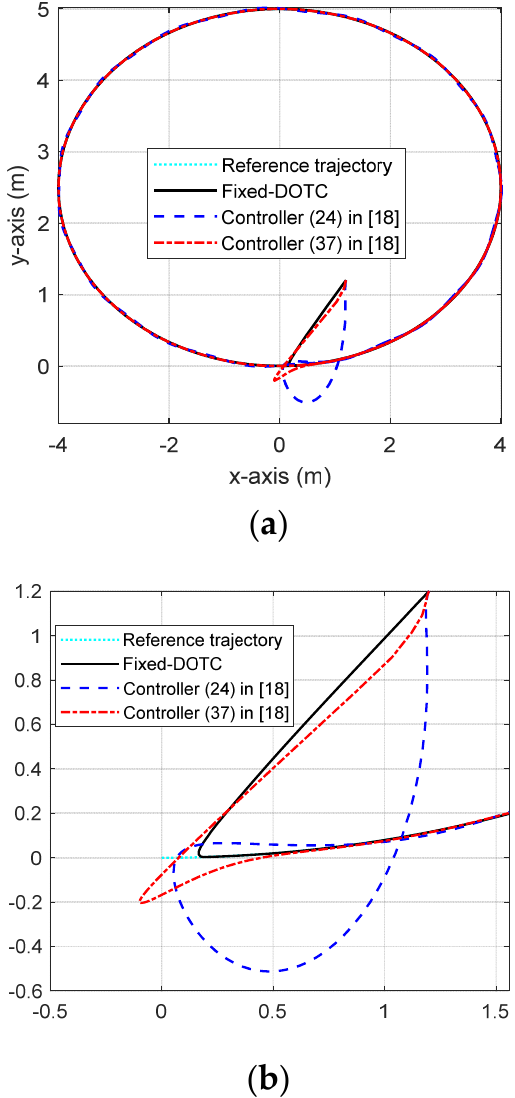
Figure 5. The actual position trajectory and the desired position trajectory in part 1; ( a ) the whole trajectories, ( b ) zoom of the trajectories at the beginning.